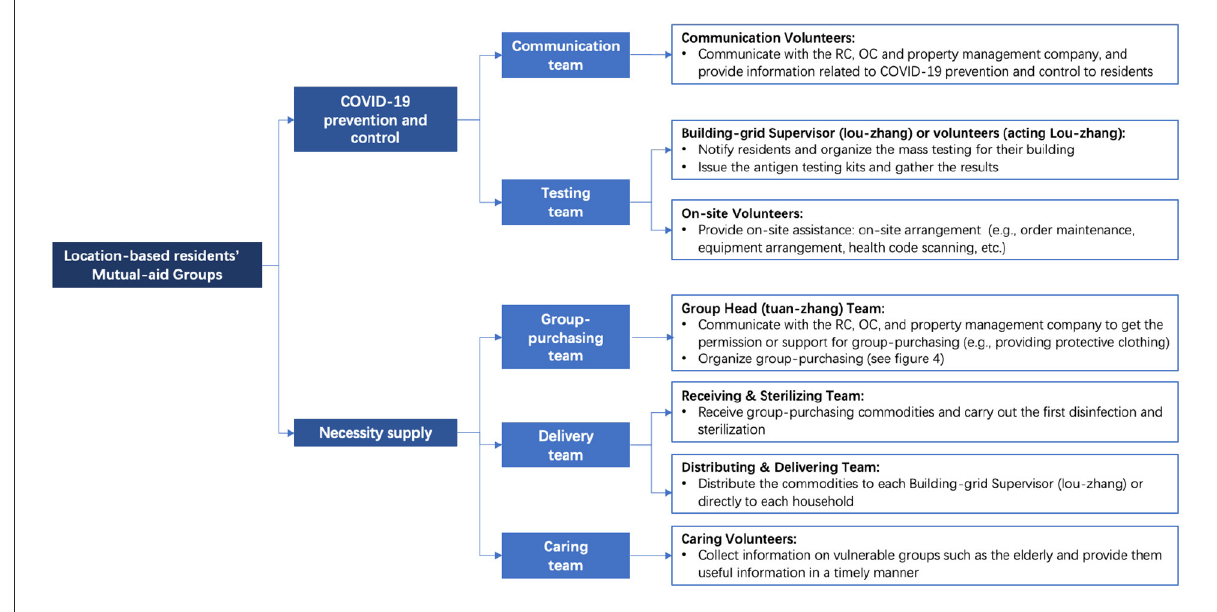
FIGURE3 Typical structure and work division of residents’ mutual-aid spontaneous group.